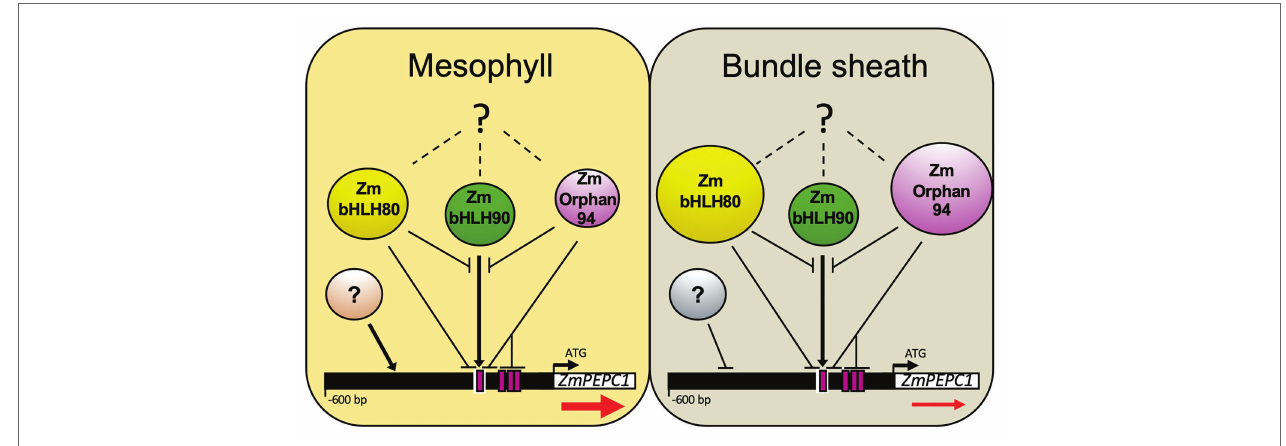
FIGURE 7 | Model integrating the contribution of ZmOrphan94, ZmbHLH80, and ZmbHLH90 to regulate M-specific ZmPEPC1 expression. ZmOrphan94 and ZmbHLH80 are repressors, whereas ZmbHLH90 is an activator of ZmPEPC1 expression. ZmOrphan94 and ZmbHLH80 impair ZmbHLH90-mediated ZmPEPC1 activation through competitive binding to the same cis -element (E-Box; white rectangle) and/or heterodimerization. ZmOrphan94 can also impair ZmbHLH90- mediated ZmPEPC1 activation through its binding to the CACA motifs (magenta rectangles) present within the ZmPEPC1 upstream region, being that one of them is present within the E-Box (white rectangle). ZmOrphan94 and ZmbHLH80 are preferentially expressed in BS cells, thus having a predominant role repressing ZmPEPC1 expression in this cell type. Dashed lines with question marks represent mechanisms that may regulate ZmOrphan94, ZmbHLH80, and ZmbHLH90 post- transcriptionally. Question marks in circles represent yet unidentified TFs that may be involved in M-specific ZmPEPC1 expression. Arrows and horizontal lines indicate activation and repression, respectively. Sizes of ZmOrphan94, ZmbHLH80, and ZmbHLH90 circles represent differences in transcript abundance. Red arrows below ZmPEPC1 gene indicate the difference in ZmPEPC1 transcript abundance between M and BS